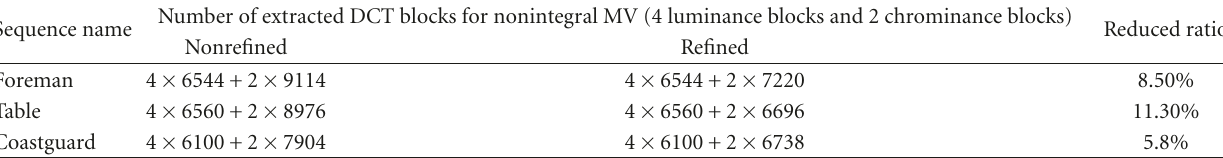
Table 4: Reduced ratio of nonintegral in